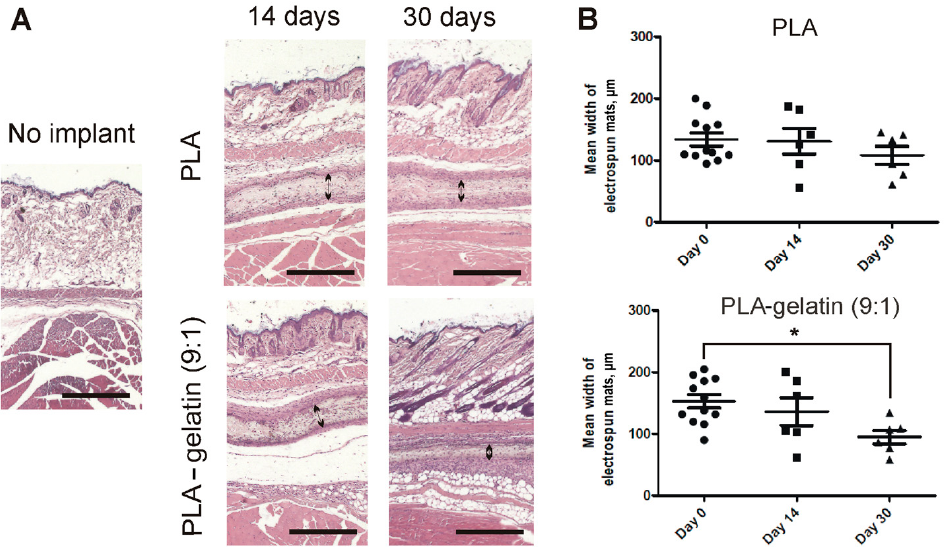
Figure 8. In vivo biodegradation analysis of PLA and PLA–gelatin electrospun mats. ( A ) Histological images of PLA and PLA–gelatin discs on days 14 and 30 after subcutaneous implantation in C57black/6 mice. A double-ended arrow indicates the thickness of the implanted biomaterial. The scale bar is 500 μ m. ( B ) Change in electrospun mat thickness over time. The data are presented as mean±SD. * p < 0.05 one-way ANOVA followed by a post hoc Dunnett’s t -test.